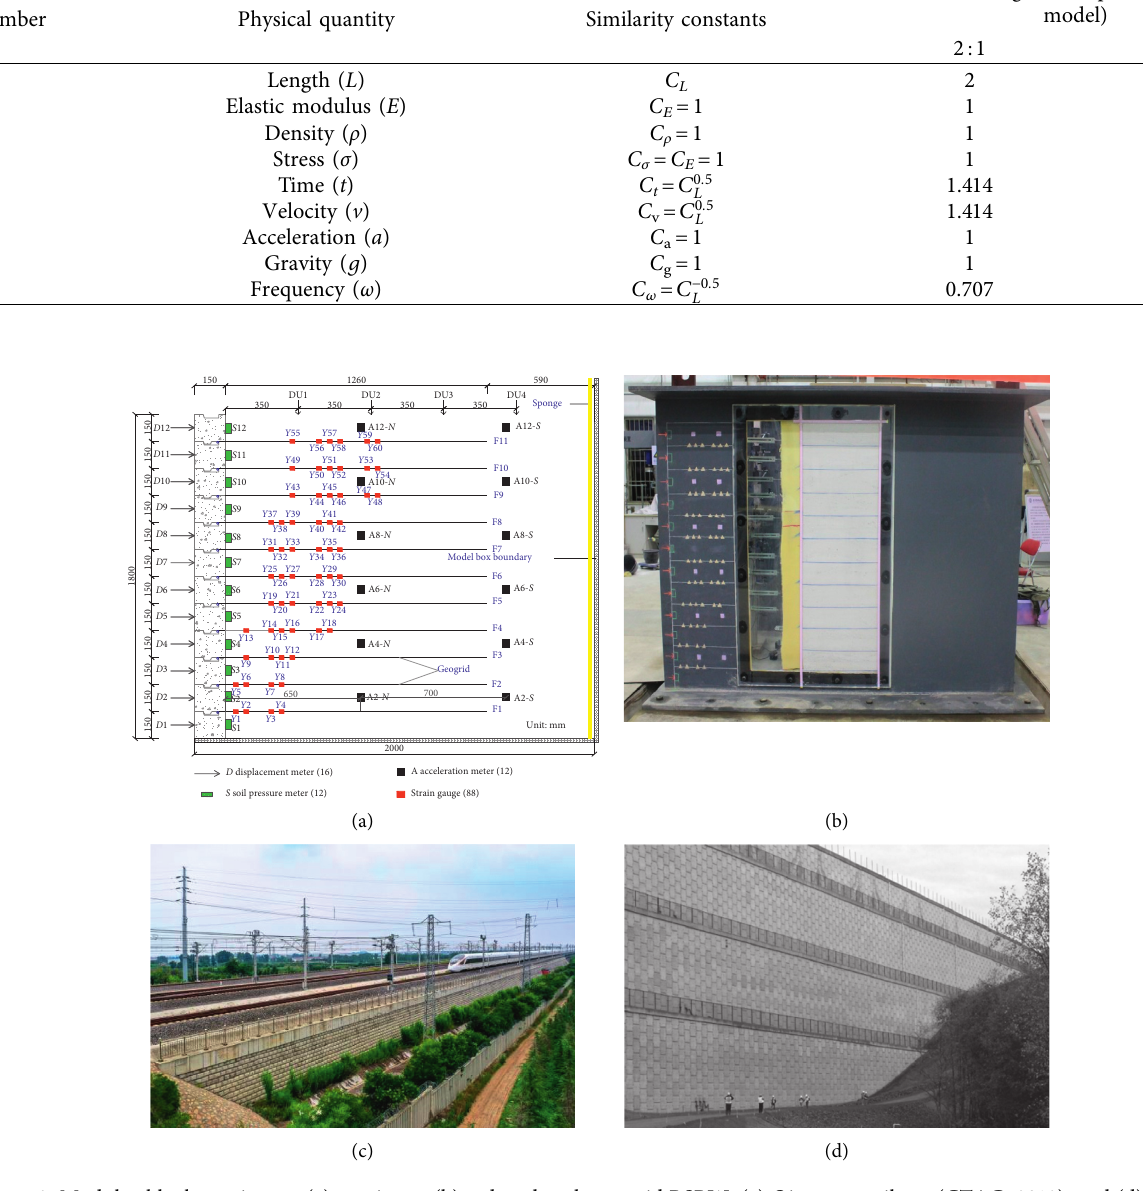
Figure 2: Modular-block specimens: (a) specimen, (b) reduced-scale geogrid RSRW, (c) Qingrong railway (CTAG, 2019), and (d) SeaTac airport runway (FHWA,